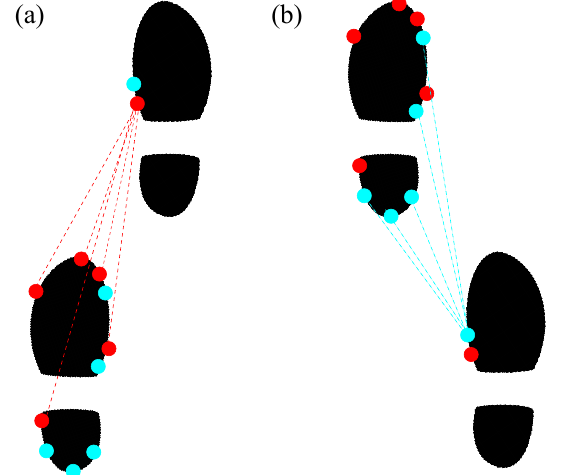
Figure 1. The setup of the ultrasound sensors. The ultrasound sensors marked in red are active when the right leg is the leading leg during walking ( a ). The ultrasound sensors marked in blue are active when the left leg is the leading leg during walking ( b